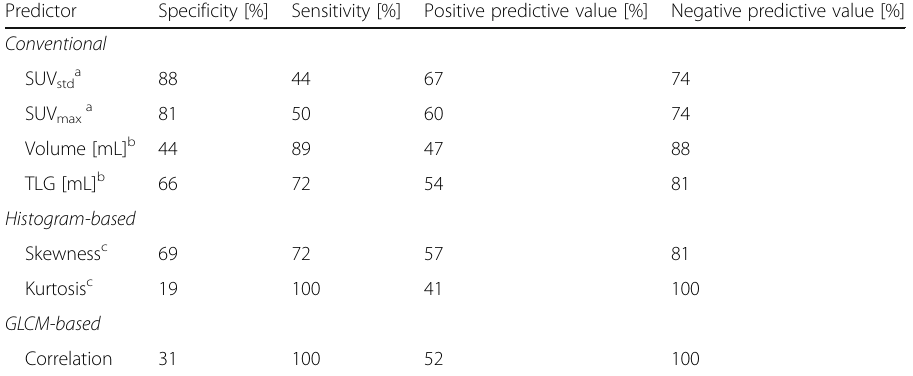
Table 6 Summary of predictive power of the significant predictors